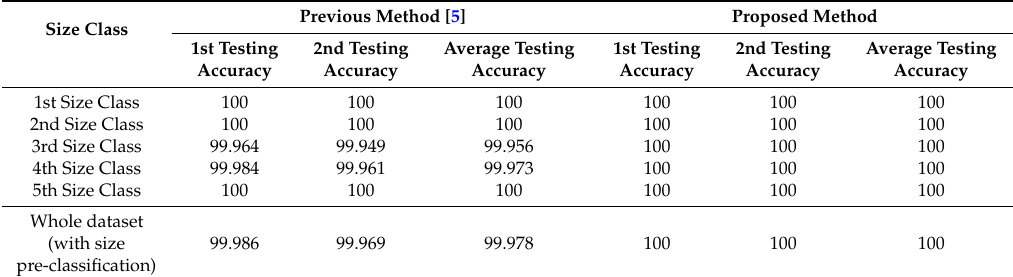
Table 6. Testing results of the proposed method in comparison with those of the previous study on separated size classes (unit: %). 1st Testing Accuracy and 2nd Testing Accuracy mean the accuracies of the testing on the 1st and 2nd subsets of banknote images in the two-fold cross-validation method, respectively.